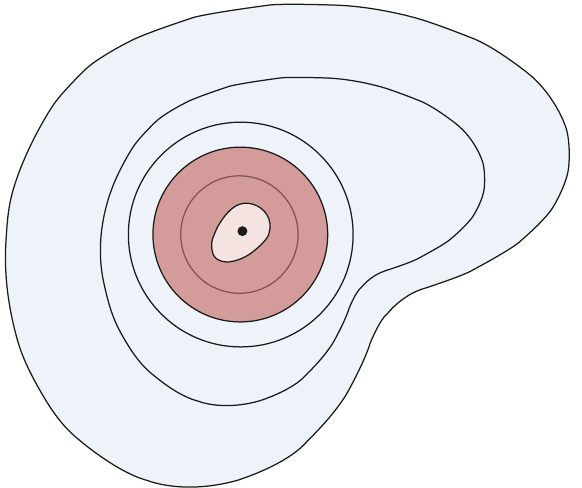
Figure 1: A schematic figure of the (sub)level sets in Theorem 11. Outward from the equilibrium (thick dot): 𝜕 B = 𝑉 −1 (0) ⊂ 𝑊 −1 ([0,𝛽𝑊 ]) ⊂ 𝑊 −1 ([0,𝑊 ]) and then 𝑉 −1 ([0,𝜆]) ⊂ max max 𝑉 −1 ([0,𝛼]) ⊂ 𝑉 −1 ([0,1]) = 𝜕 A . In particular, 𝑊 −1 (𝑊 ) ⊂ max 𝑉 −1 ([0,𝜆]) . The local Lyapunov function 𝑊 asserts that a solution starting in the innermost area leaves the red area with probability no higher than 𝛽 and the nonlocal Lyapunov function 𝑉 asserts that a solution leaving the red area goes to the innermost area with probability no less than 1 − 𝜆